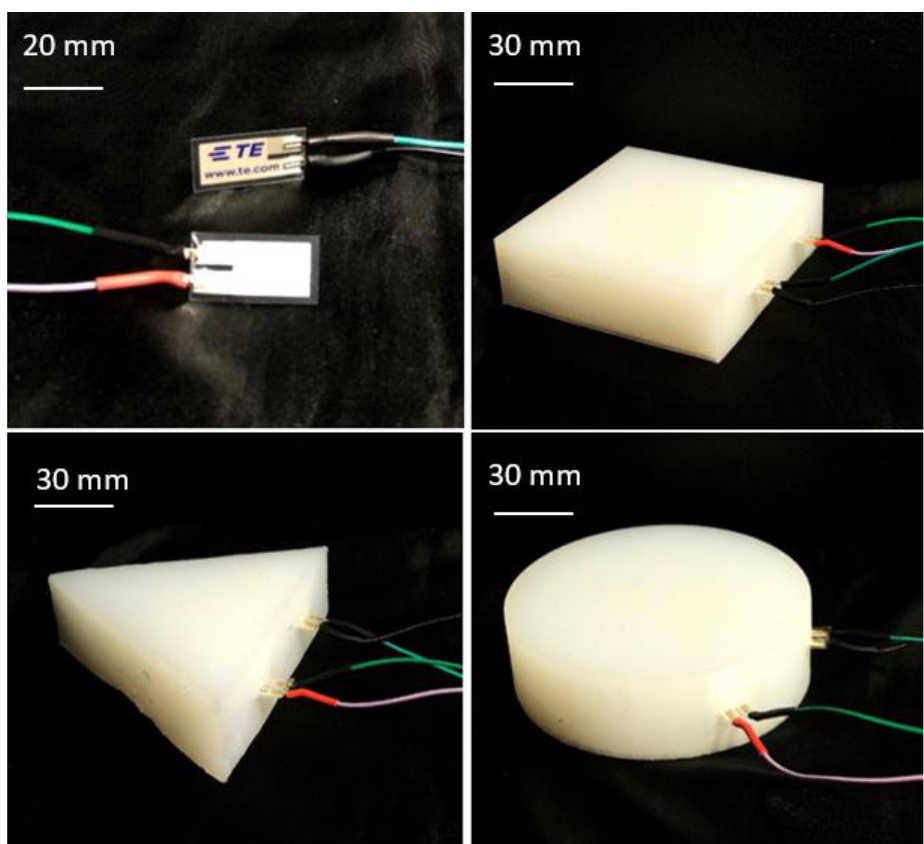
Figure 3. PVDF sensor with soldered wire and heat shrink; sensors embedded inside the silicon modules.